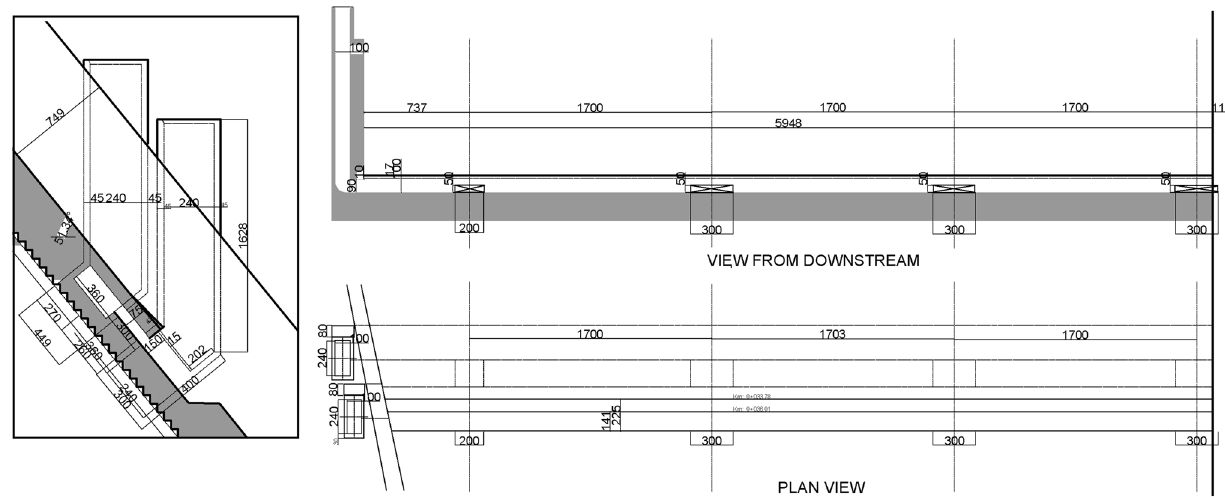
Fig. 1 The details of spillway aerator geometry Table 1 Discharge values selected for the model experiment and their tailwater levels (Özcan 2011) Discharges, Q (m 3 /s)